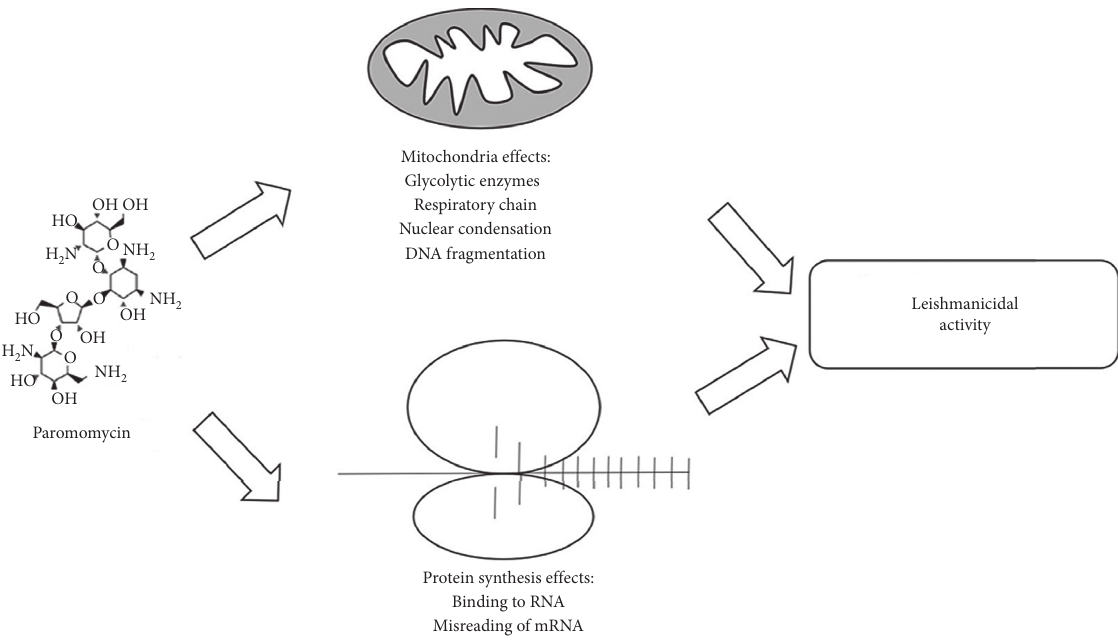
Figure 1: Mechanism showing leishmanicidal activity of